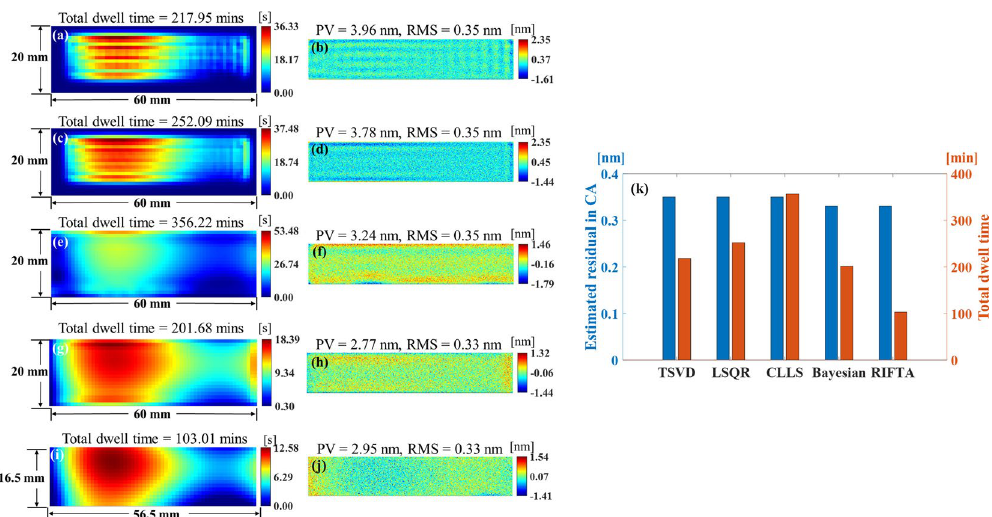
Figure 6. Dwell time maps and estimated residual maps in the CA calculated using TSVD ( a , b ), LSQR ( c , d ), CLLS ( e , f ), Bayesian-based algorithm ( g , h ), and RIFTA (i , j ). The RIFTA achieves the best performance in terms of both the smallest estimated residual in the CA and the shortest total dwell time ( k